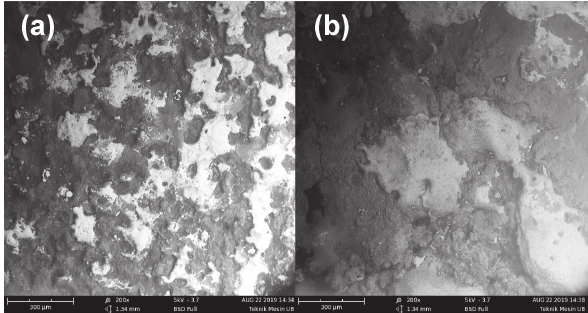
Figure 2: SEM images of BMG machined surface at (a) 4 A, 50 µ s combination and (a) 12 A, 150 µ s combination using 200 times